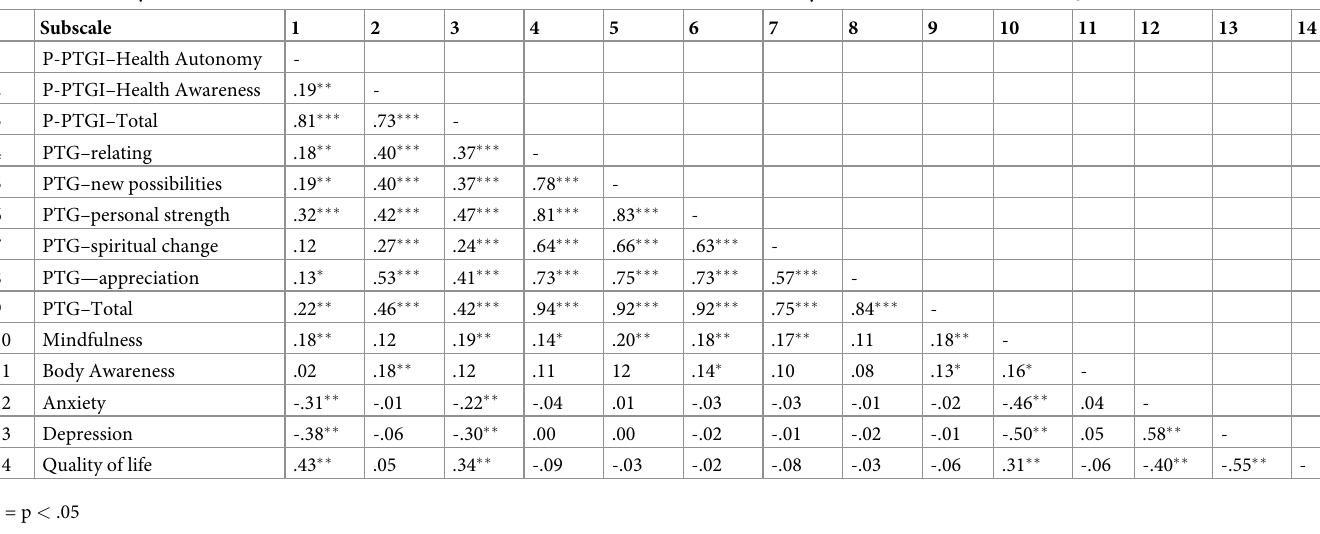
Table 5. Summary of inter-correlations for subscales and total P-PTGI, PTG, mindfulness and body awareness scores, HADS and QoL. Subscale